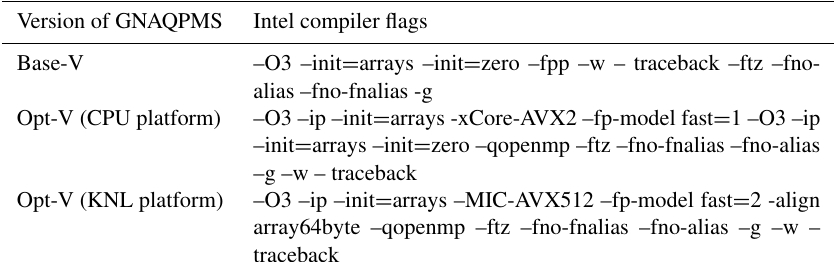
Table 3. Compile flags of Base-V GNAQPMS and Opt-V GNAQPMS on the CPU and KNL platforms.